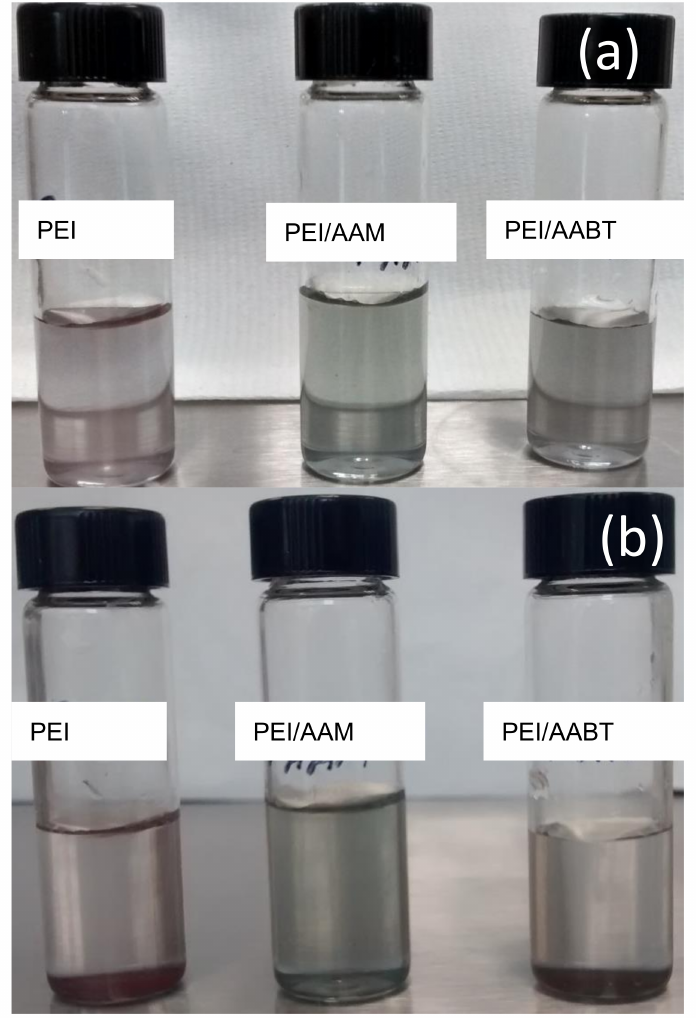
Figure 7. Colloidal stability of the Cu NPs ( a ) after 10 h of dispersion, and ( b ) after 24 h of